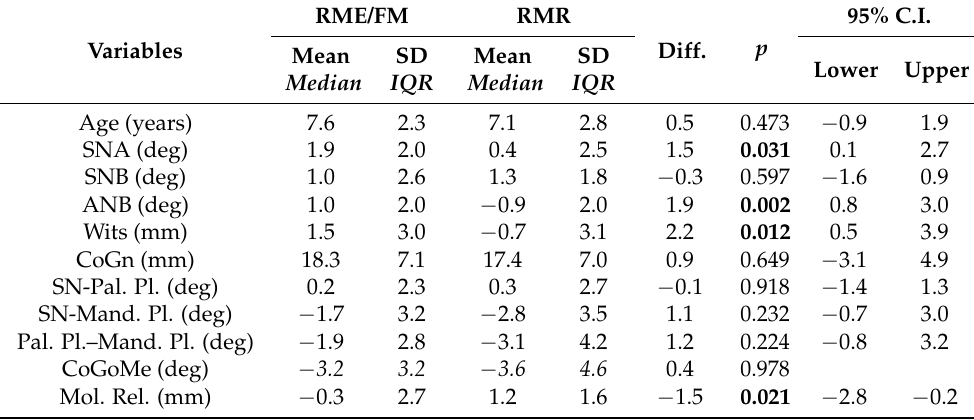
Table 2. Descriptive statistics and statistical comparisons (independent sample t test or Mann– Whitney U test) for the T1–T3